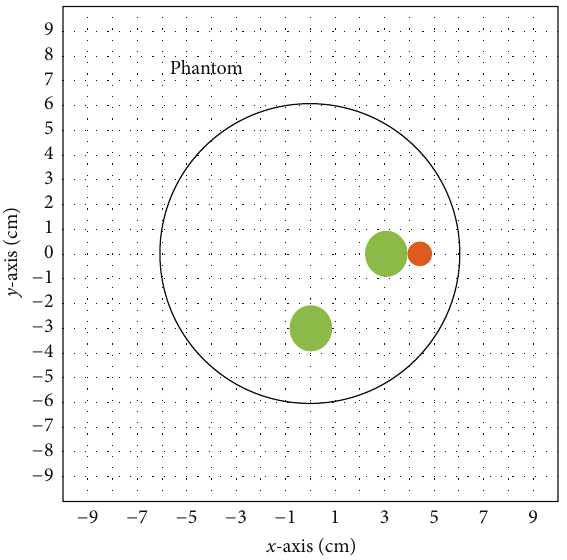
Figure 9: Experiment 2 setup. The fibroglandular structures are denoted in green and tumor is denoted in red.